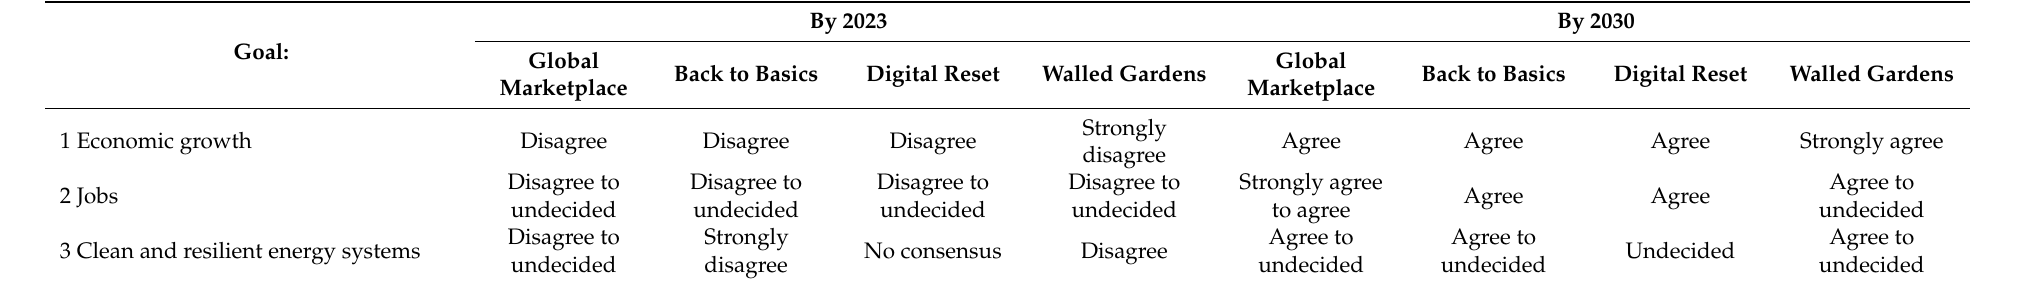
Table A10. Expert consensus if the increasing specific bioenergy demand (bioheat, bioelectricity, liquid or gaseous biofuels for transport) would generate sufficient economic growth, jobs and clean and resilient energy systems through